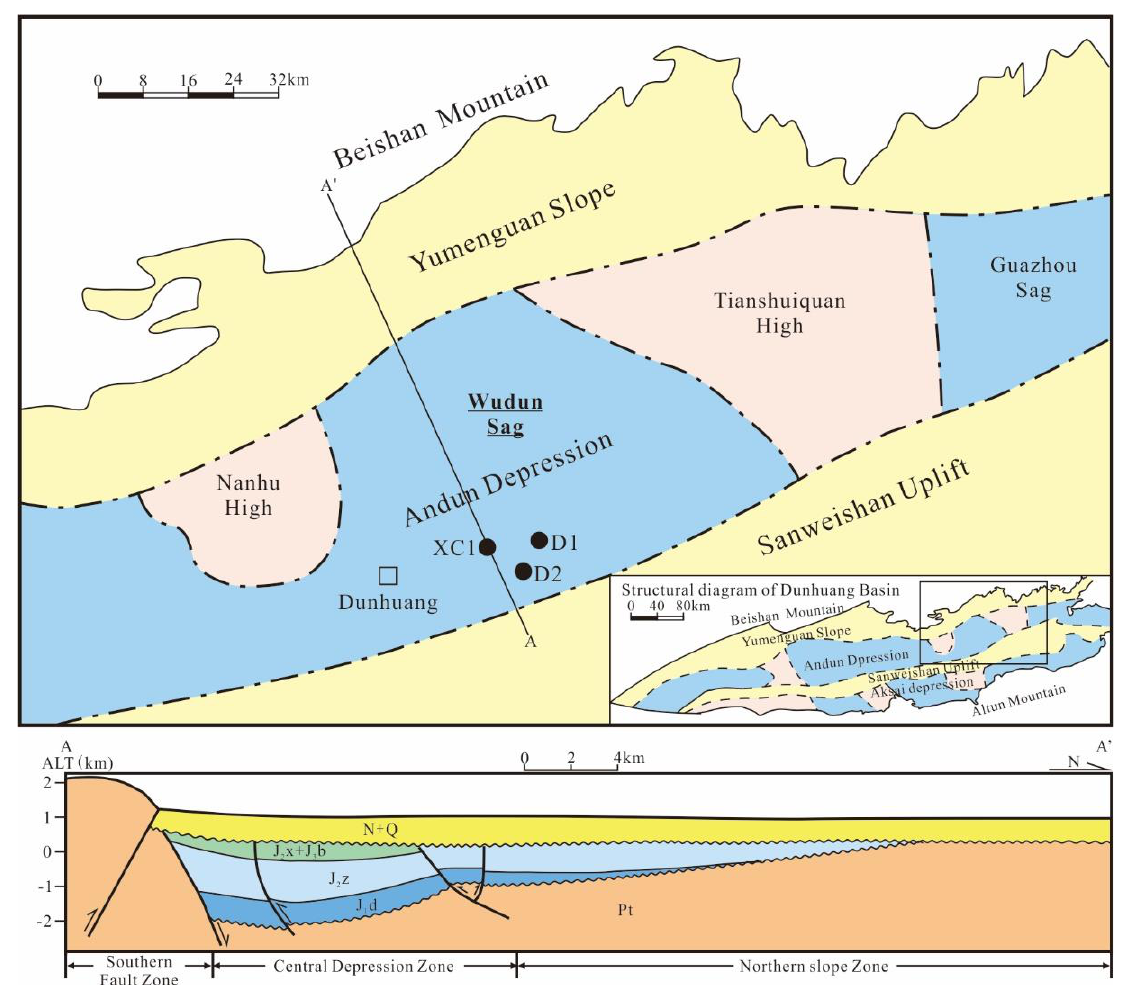
Figure 1. Tectonic location and geological section of Wudun sag.